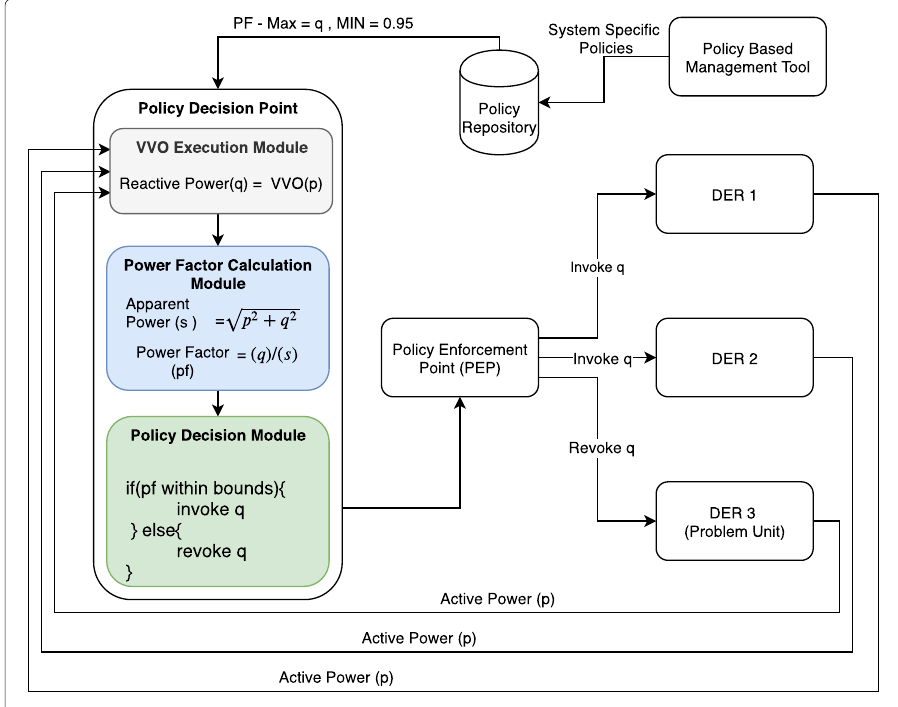
Fig. 5 Policy Based Network Management Voltage Control Validation